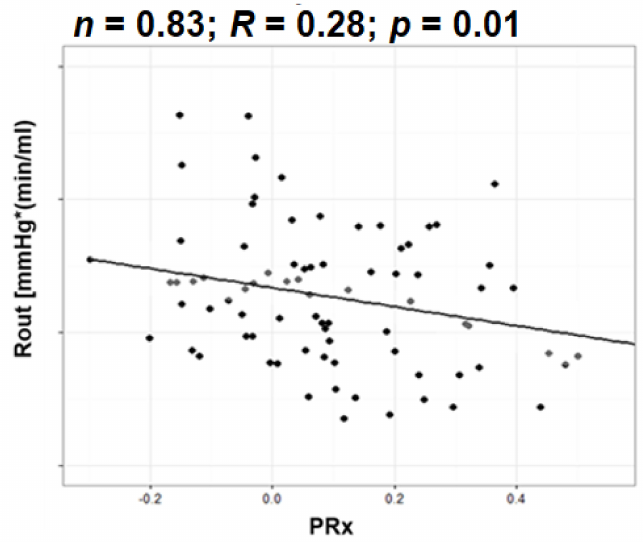
Figure 9. Inverse relationship between Rout and PRx. Data derived from lumbar infusion studies, who were selected for CSF diversion. The 83 patients included had been selected for shunting based on general clinical workup and discussion of risks versus benefits. Higher resistance and negative PRx indicate deranged CSF circulation with overall preserved global autoregulation, potentially highlighting a pathology amenable to